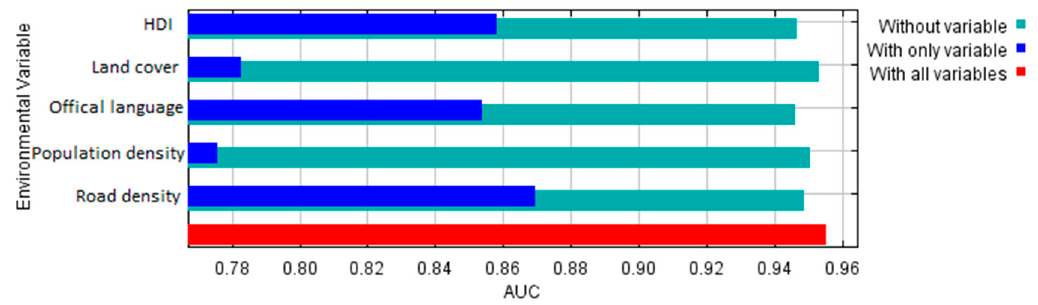
Figure 20. Jackknife test of variable importance to the Maxent model based on test AUC.